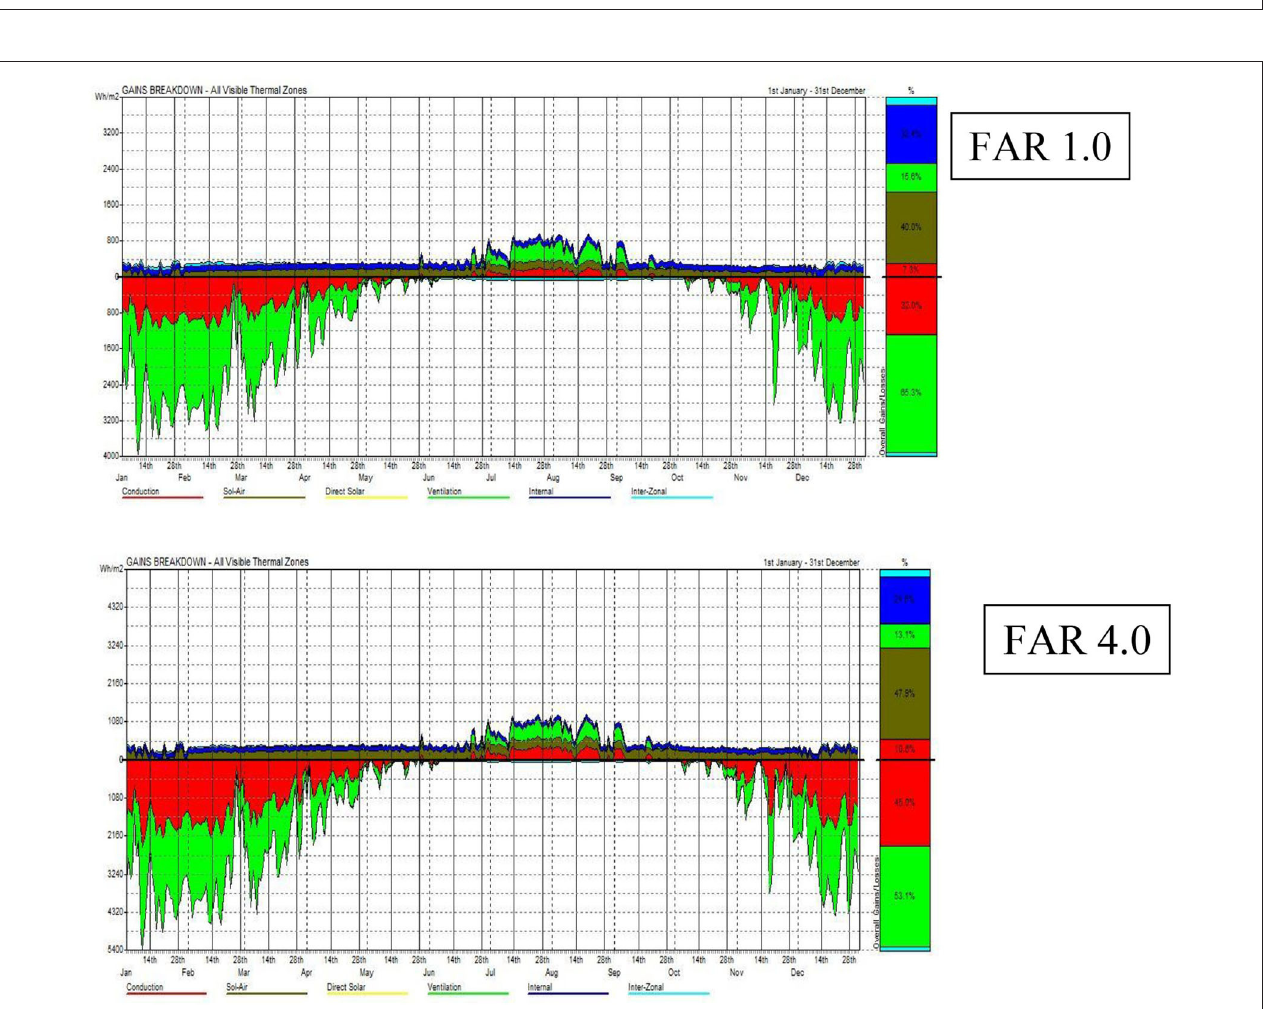
FIGURE 8 | Passive building energy gains and losses breakdown for FAR 1.0 (top) and FAR 4.0 (below). Red, conduction; dark green, sol-air; yellow, direct solar; light green, ventilation; dark blue, internal; light blue, inter-zonal.